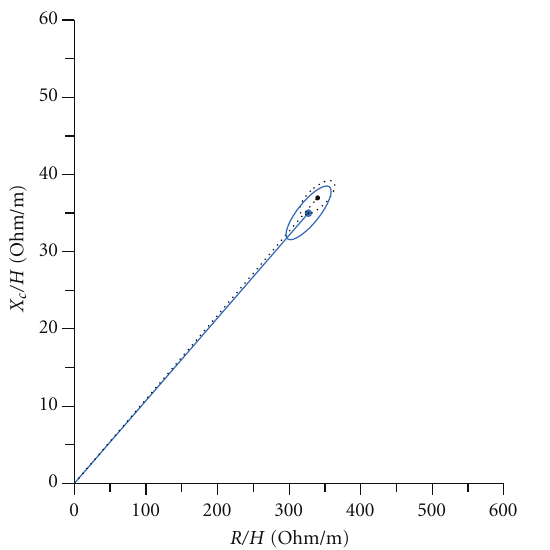
Figure 1: Mean vectors of 95% confidence limits in Taiwanese (black dotted line) and Polish (solid blue line) college men.